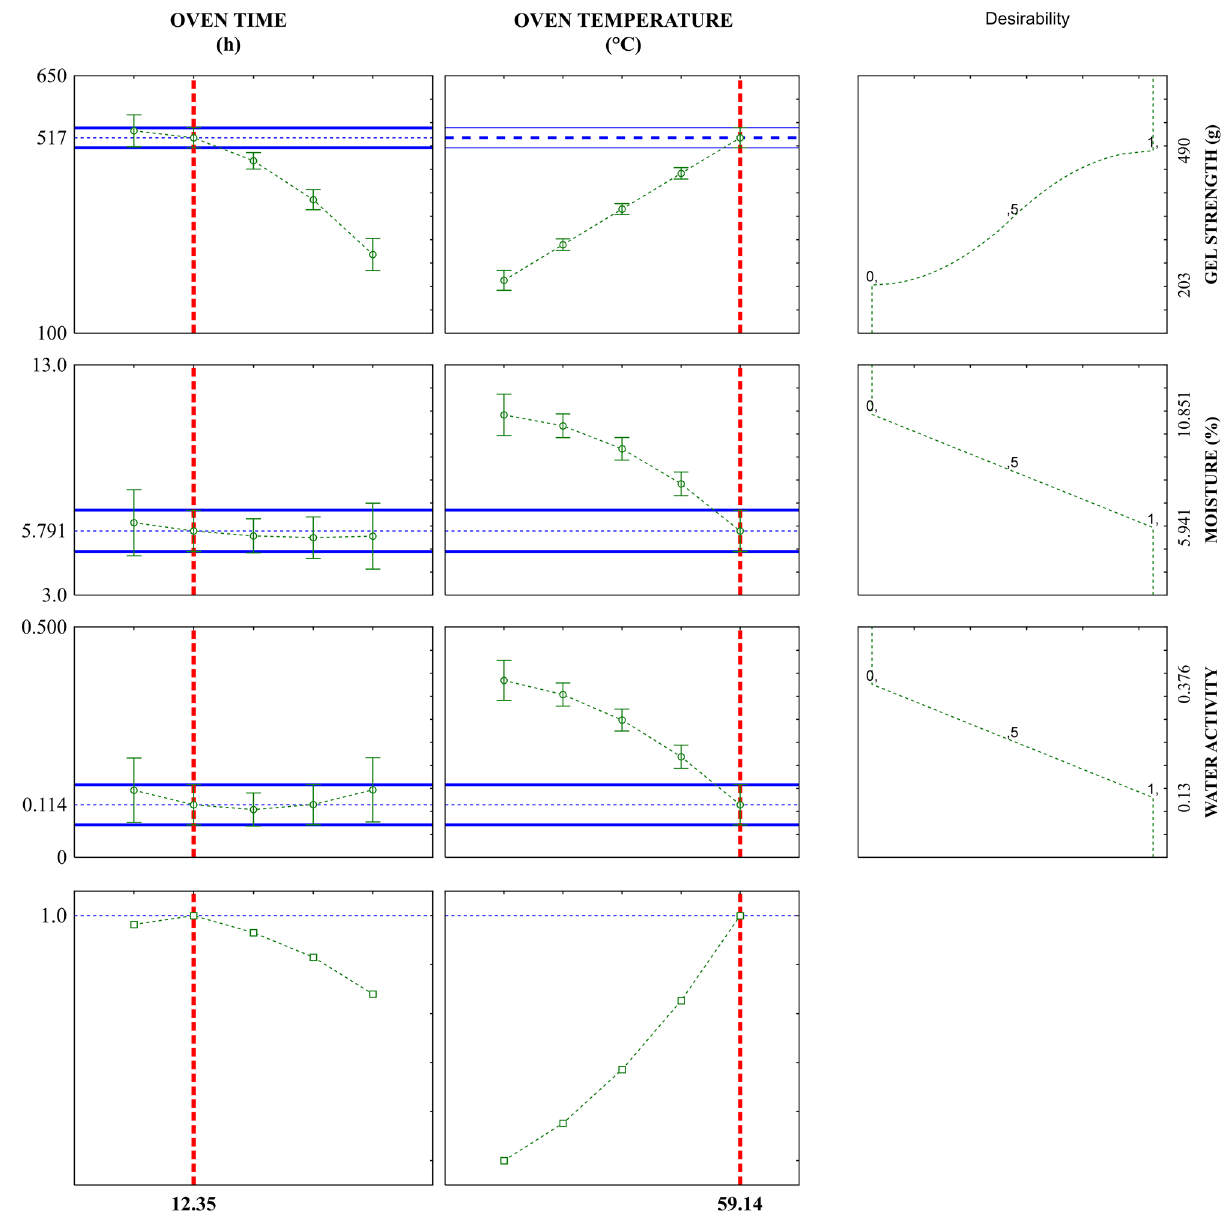
Figure 2. Desirability profiles for oven time and temperature in gelatin drying for the convective drying